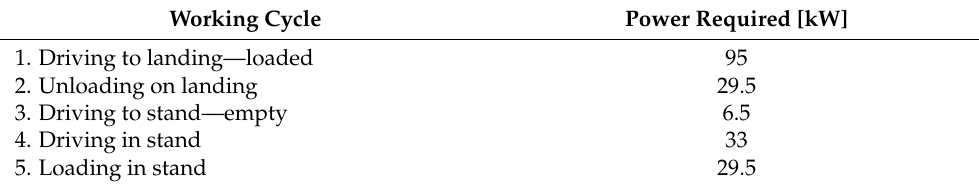
Table 2. Power values calculated for the individual parts of the working cycle of the tractor-trailer unit travelling on an unpaved